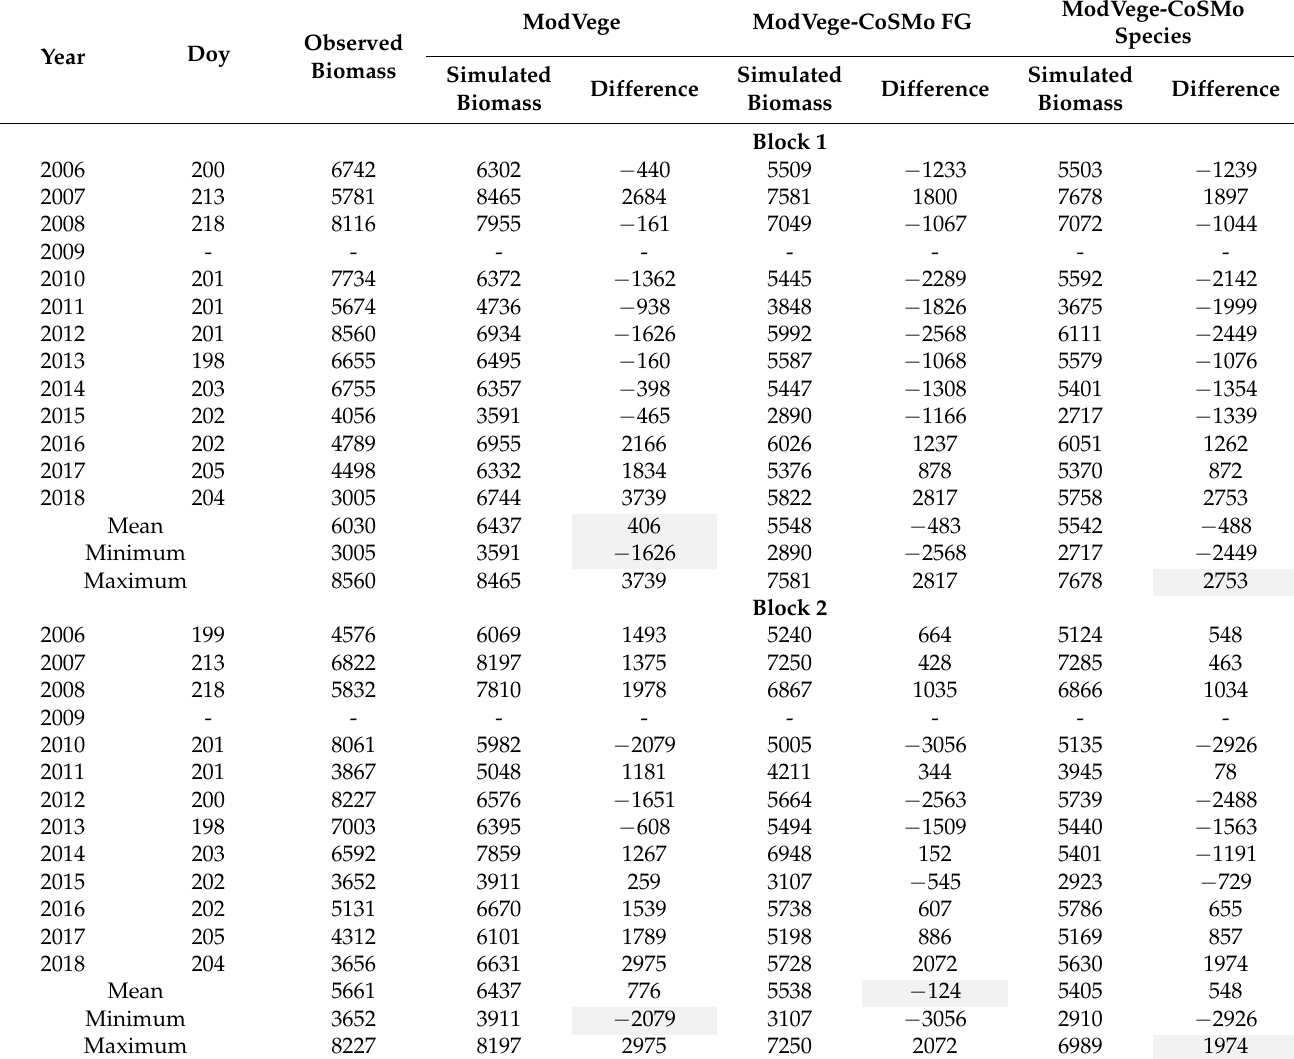
Table 4. Evaluation of alternative modelling solutions for the simulation of aboveground biomass in the summer sampling of the abandoned plots (two blocks). Grey cells indicate the best performance. FG: functional